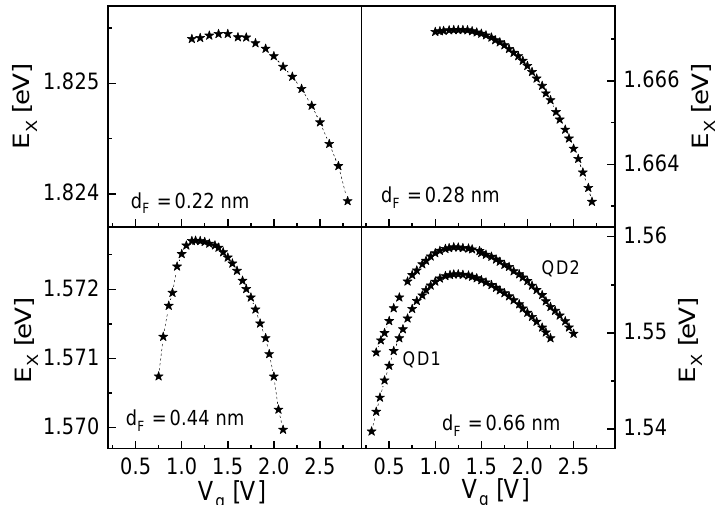
Figure 3. Measured exciton energies E X for CSQSs with varied filling layer thickness d F as a function of the gate voltage V g . Data from two CSQSs (QD1, QD2) are shown for d F = 0.66 nm.